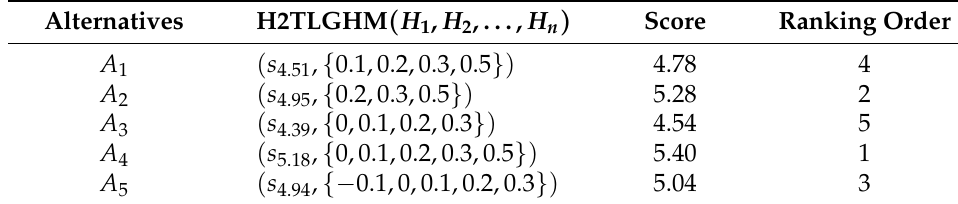
Table 12. Ranking of alternatives by using H2TLGHM operator when p = 1, q = 2.